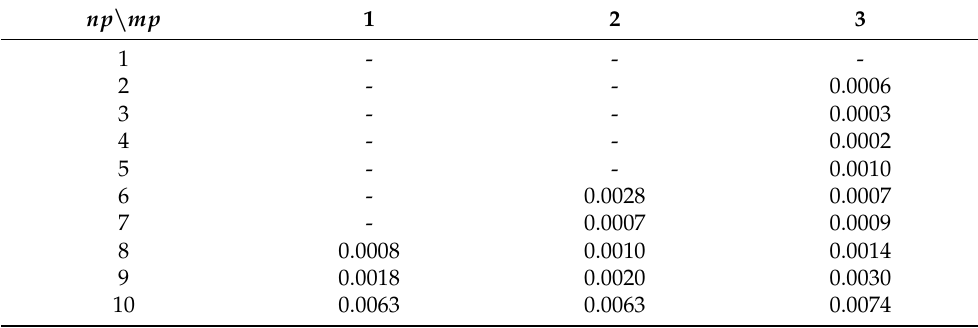
Table 5. Newton errors of the last iteration for u x obtained with Legendre collocation with a mesh 16 × 10 varying the number of horizontal ( np ) and vertical ( mp ) subdomains; Ra = 5000 and Γ =